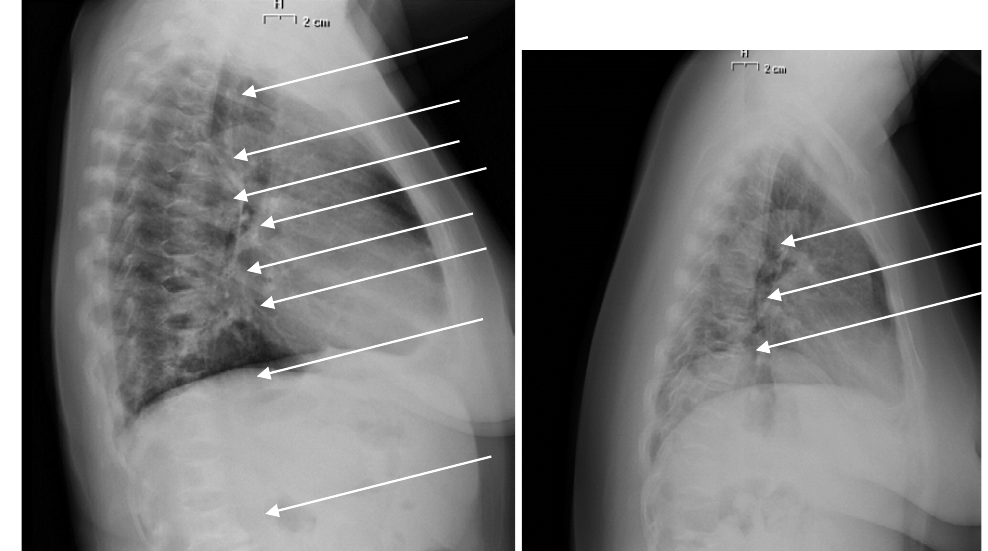
Figure 3. Thoracic x-ray of patients with vertebral fractures (arrows).